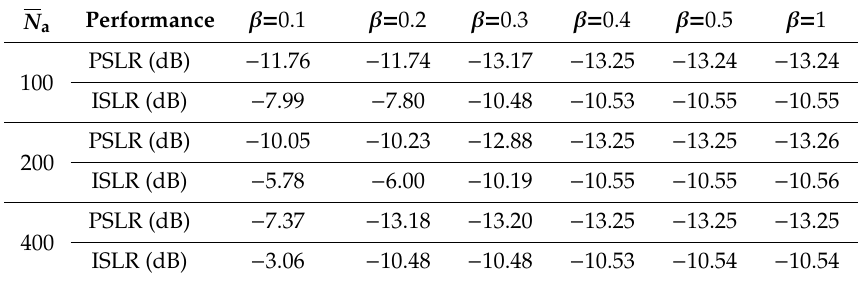
Table 4. The performances of di ff erent available data lengths for the same removed data recovery.